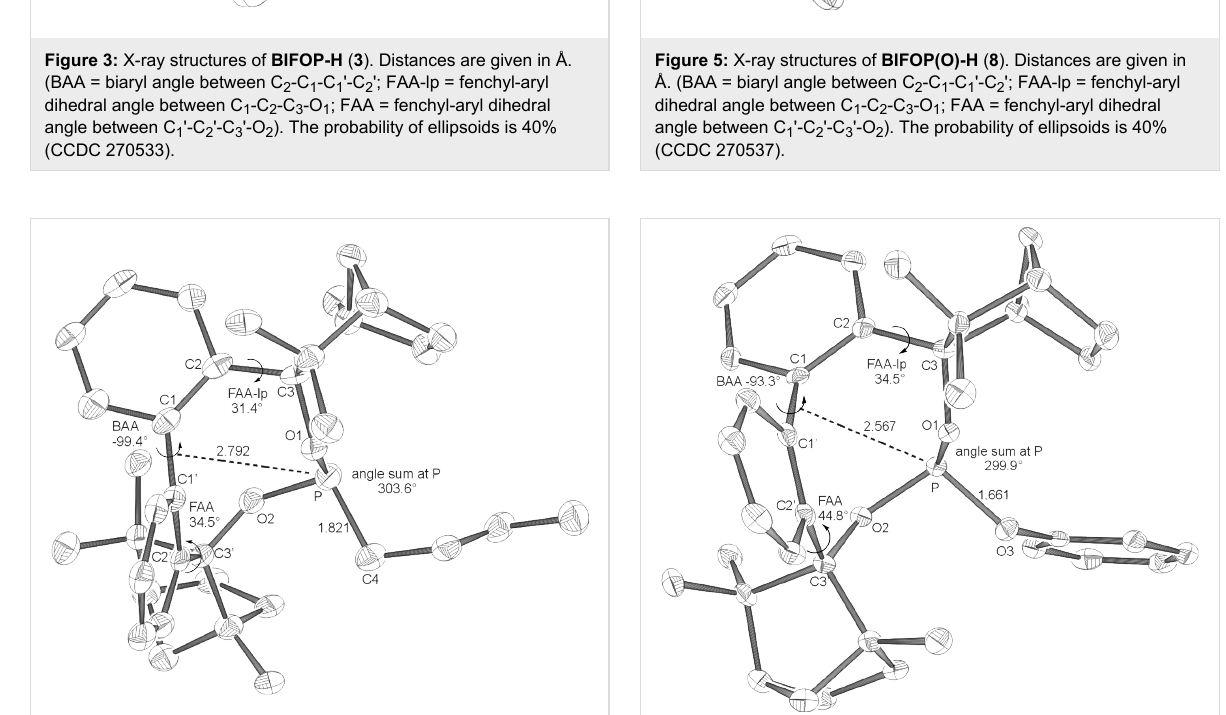
Figure 4: X-ray structures of BIFOP- n Bu ( 5 ). Distances are given in Å. (BAA = biaryl angle between C 2 -C 1 -C 1 '-C 2 '; FAA-lp = fenchyl-aryl dihedral angle between C 1 -C 2 -C 3 -O 1 ; FAA = fenchyl-aryl dihedral angle between C 1 '-C 2 '-C 3 '-O 2 ). The probability of ellipsoids is 40% (CCDC 270534).